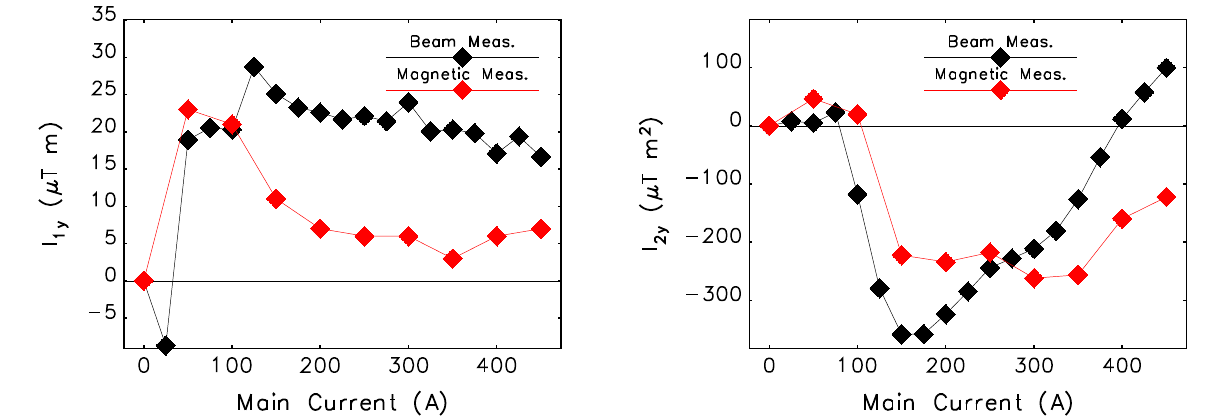
FIG. 17. Vertical-field integrals of initial correction as measured using the stored beam, before final beam-based adjustments. The first integral is on the left and the second integral is on the